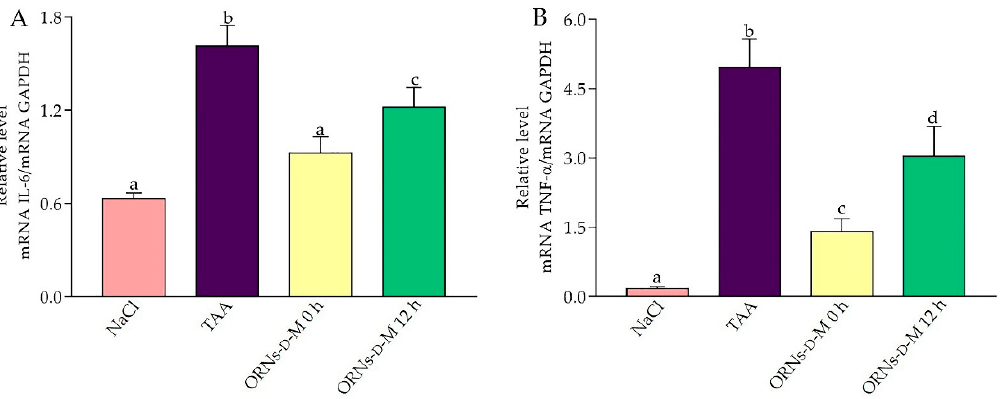
Figure 4. Effects of ORNs- D -M on the expression of IL-6 ( A ) and TNF- α ( B ) mRNA in TAA-induced liver damage mice. The investigated mRNA levels were normalized to GAPDH as a control. Data are presented as the mean ± SD, n = 6 for each group. Values marked with different letters (a, b, c, d) are statistically different, p < 0.05 (Student’s t -test). Abbreviations: NaCl—control mice receiving a single injection of NaCl; TAA—mice receiving a single injection of TAA; ORNs- D -M 0 h—mice receiving a TAA and ORNs- D -M immediately after TAA application (i.e., 0 h) and every next 12 h for 48 h; ORNs-